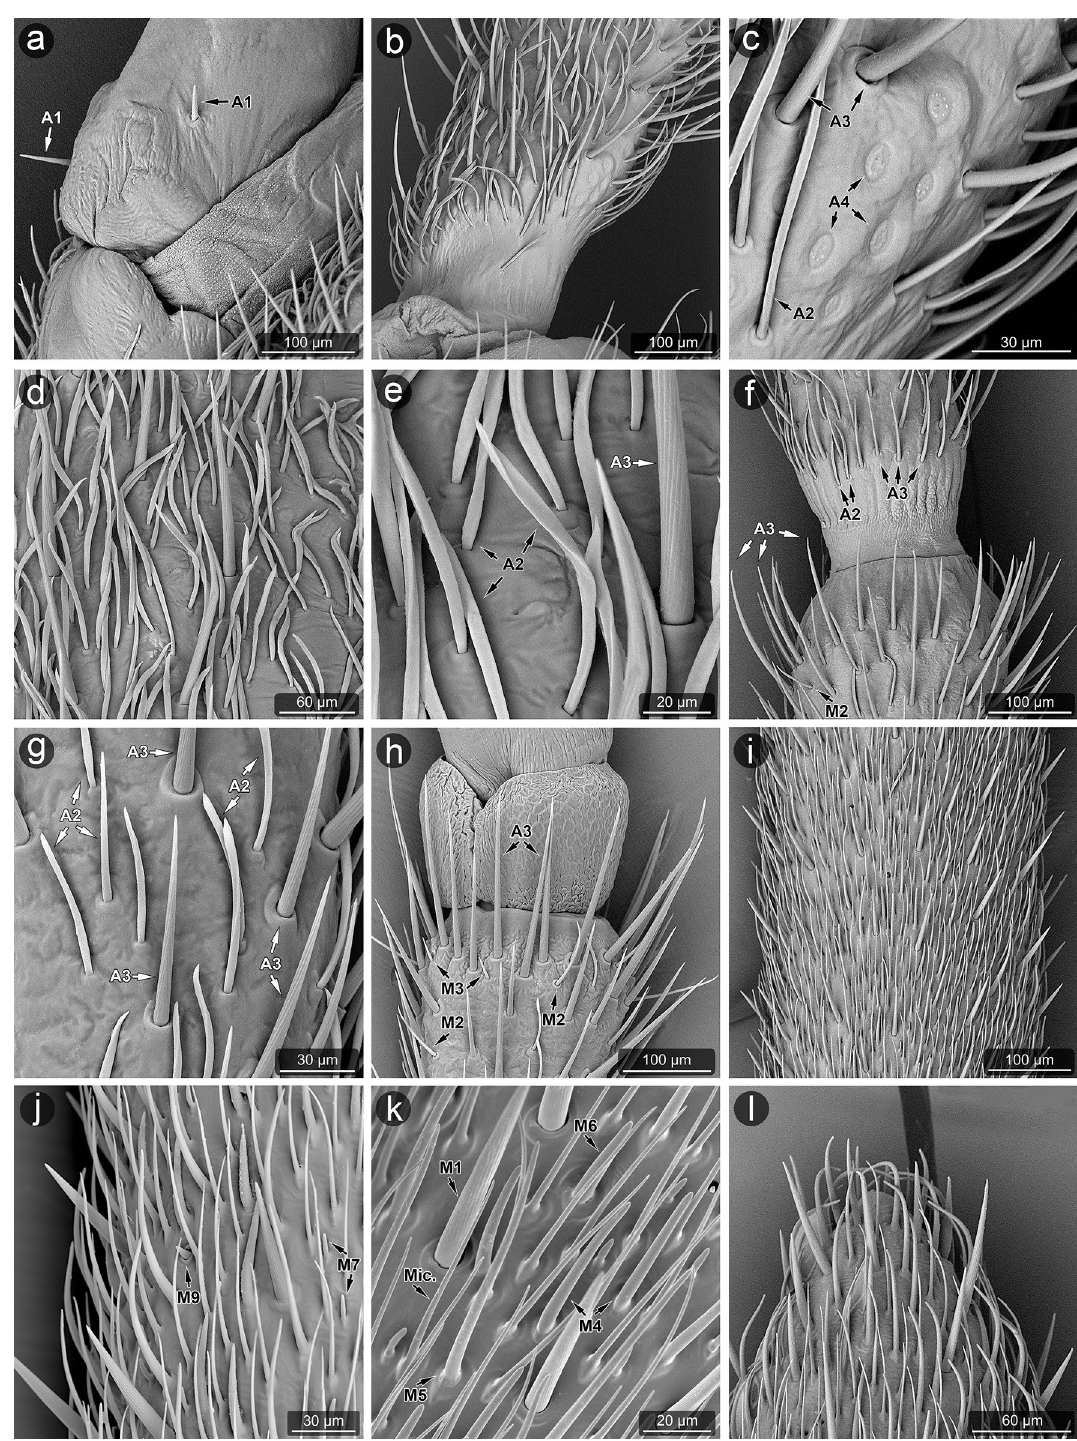
Figure 4. Morphology of selected parts of antennae analyzed in SEM: L. zonatus , the base of scape ( a ); L. occidentalis , the base of scape ( b ) and area with campaniform sensilla—A4 at higher magnification ( c ); L. zonatus , the surface of scape ( d ), as before, at higher magnification ( e ); L. occidentalis , connection of the scape and the pedicel ( f ); L. zonatus , sensilla of the pedicel ( g ); L. zonatus , connection of the pedicel and the basiflagellum with intercalary segment ( h ); L. zonatus , the surface of distiflagellum ( i ), as before, at higher magnification ( j , k ); L. occidentalis , the apex of distiflagellum ( l